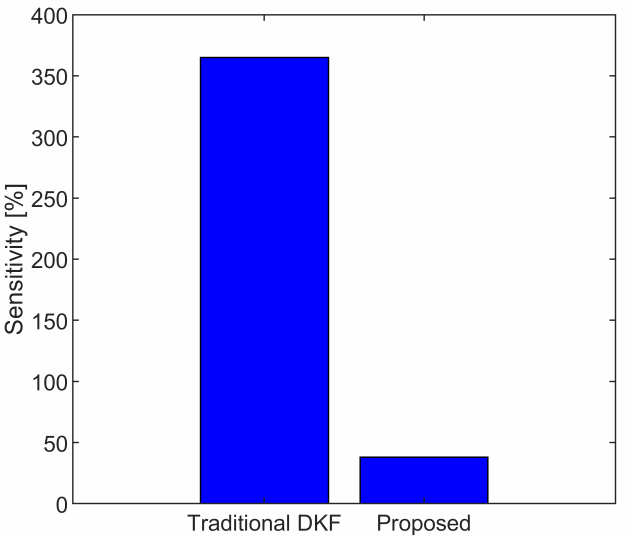
Figure 6. The results of sensitivity to temperature